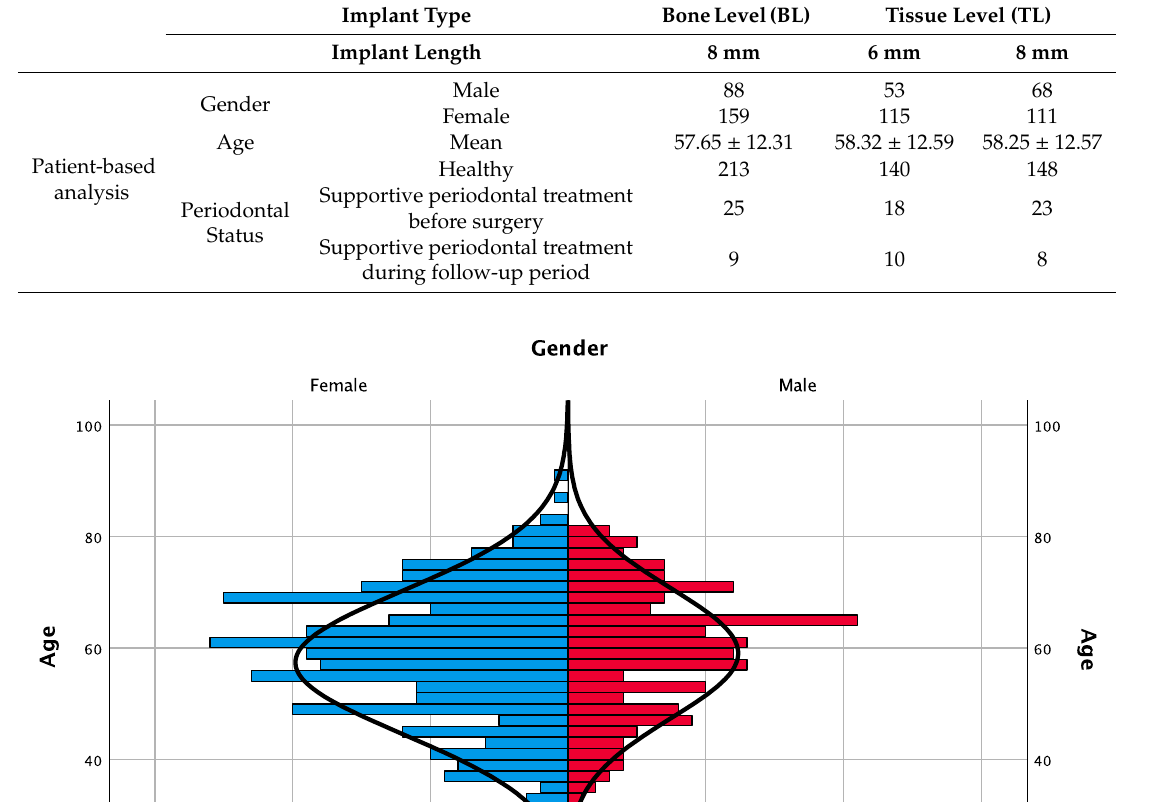
Table 1. Patient’s characteristics in each implant group ( n = patient).